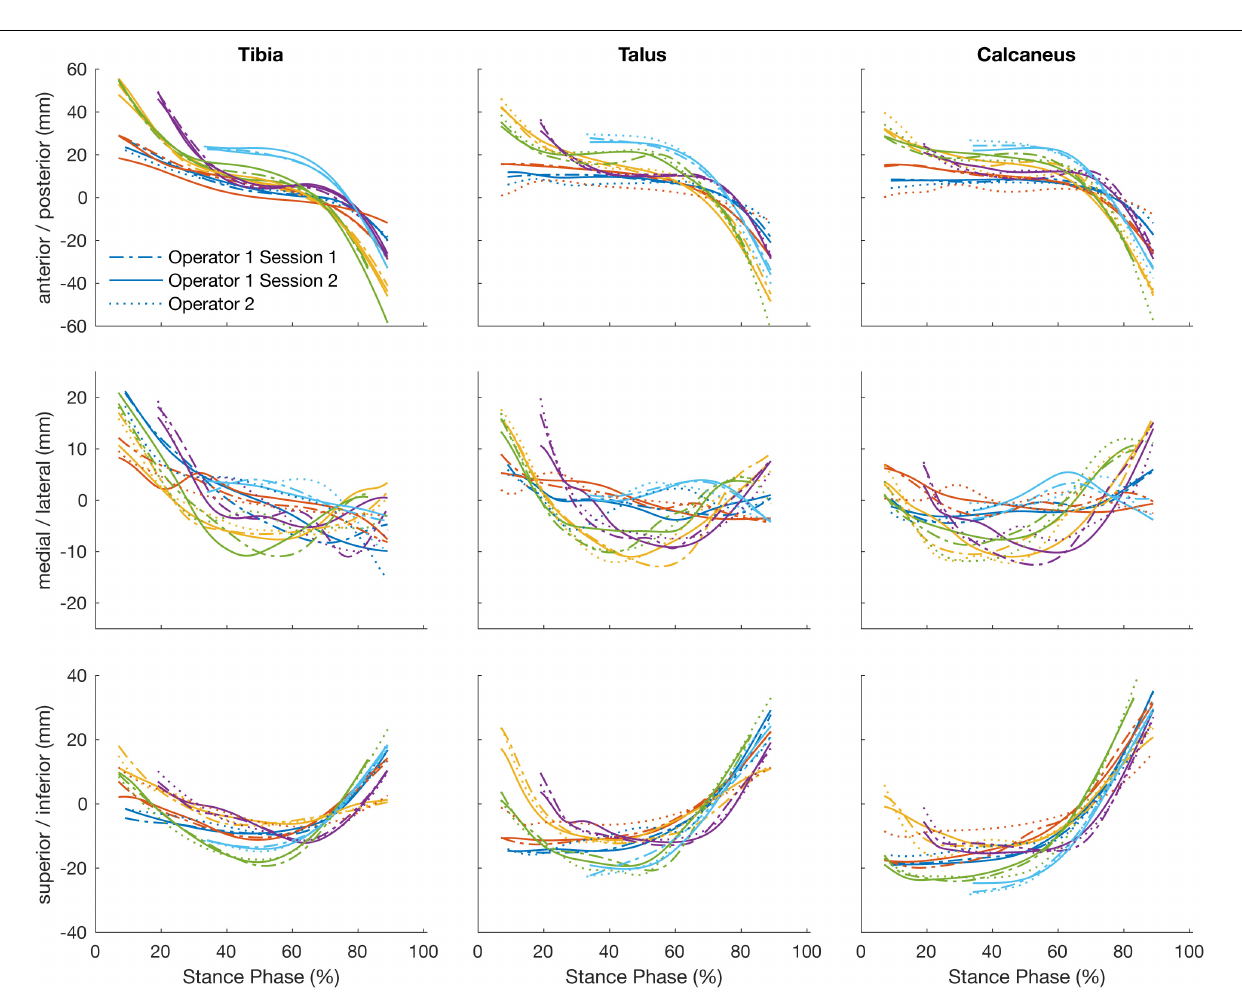
Frontiers in Bioengineering and Biotechnology |